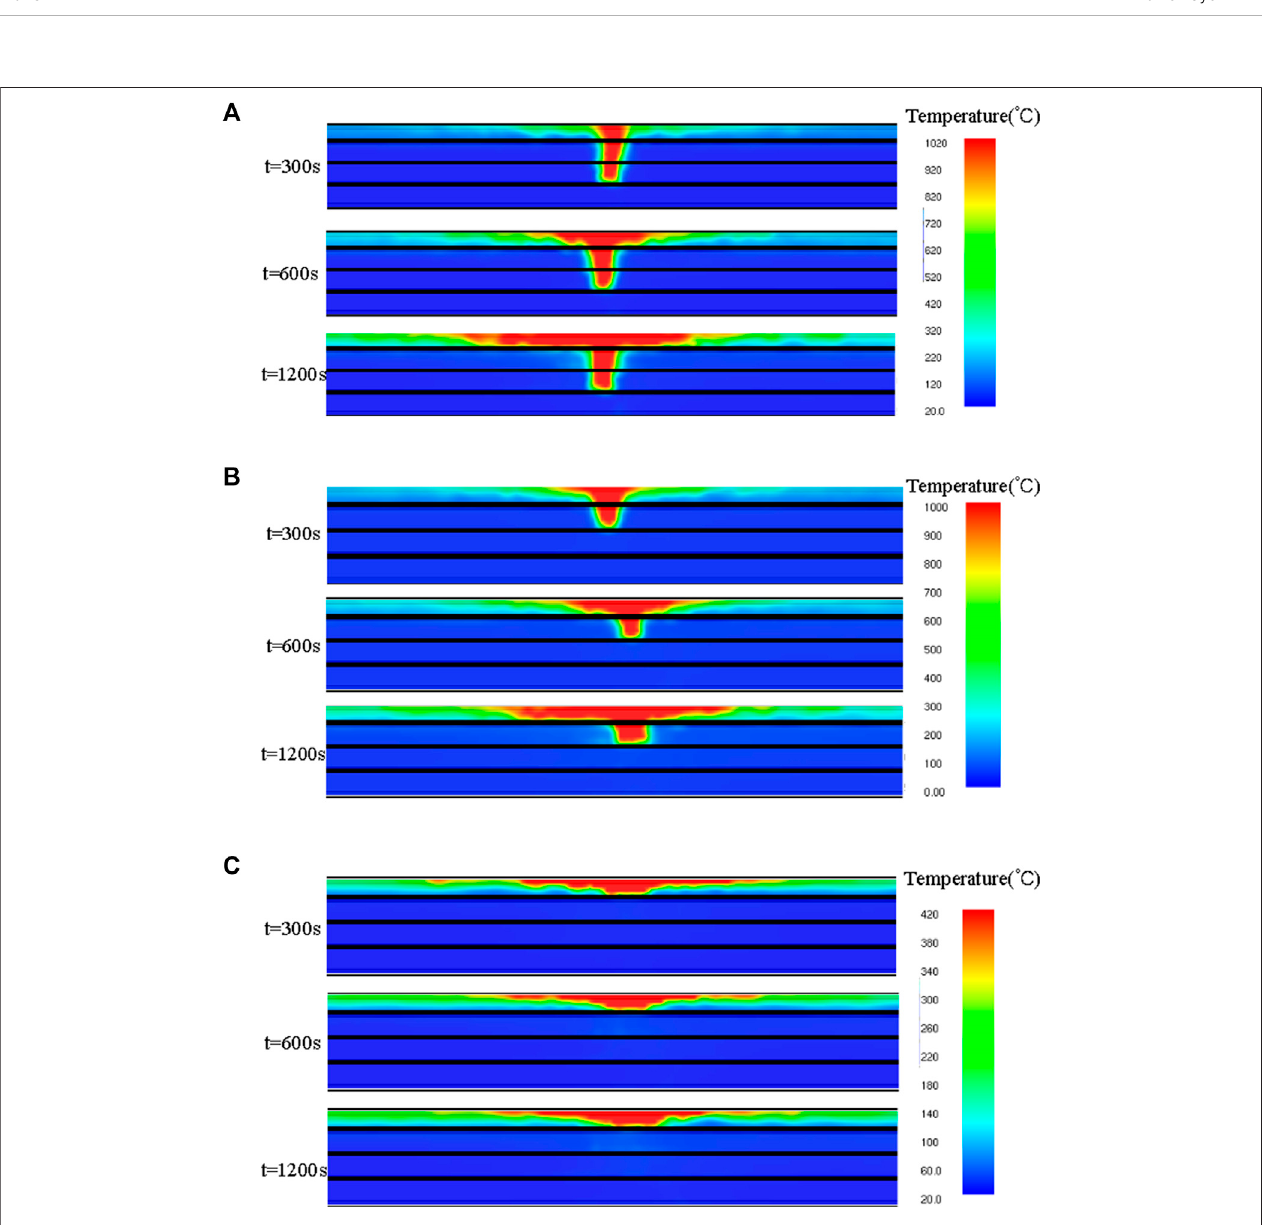
FIGURE 3 | Temperature distribution of cable tunnel when the ignition point is located in different layers. (A) At the lower layer. (B) At the middle layer. (C) At the upper layer.